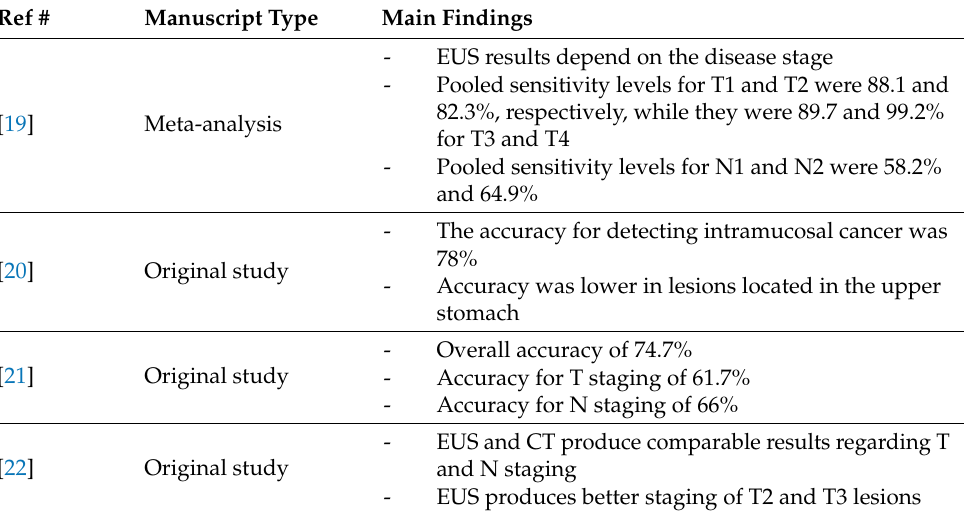
Table 1. Details of the most important papers regarding the usefulness of EUS in the staging of GC